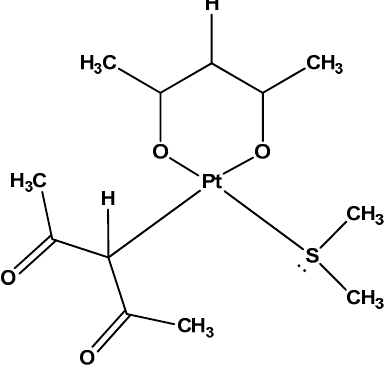
Figure 1. Chemical structure of [Pt( O , O ′ -acac)( γ -acac)(DMS)], Ptac2S.